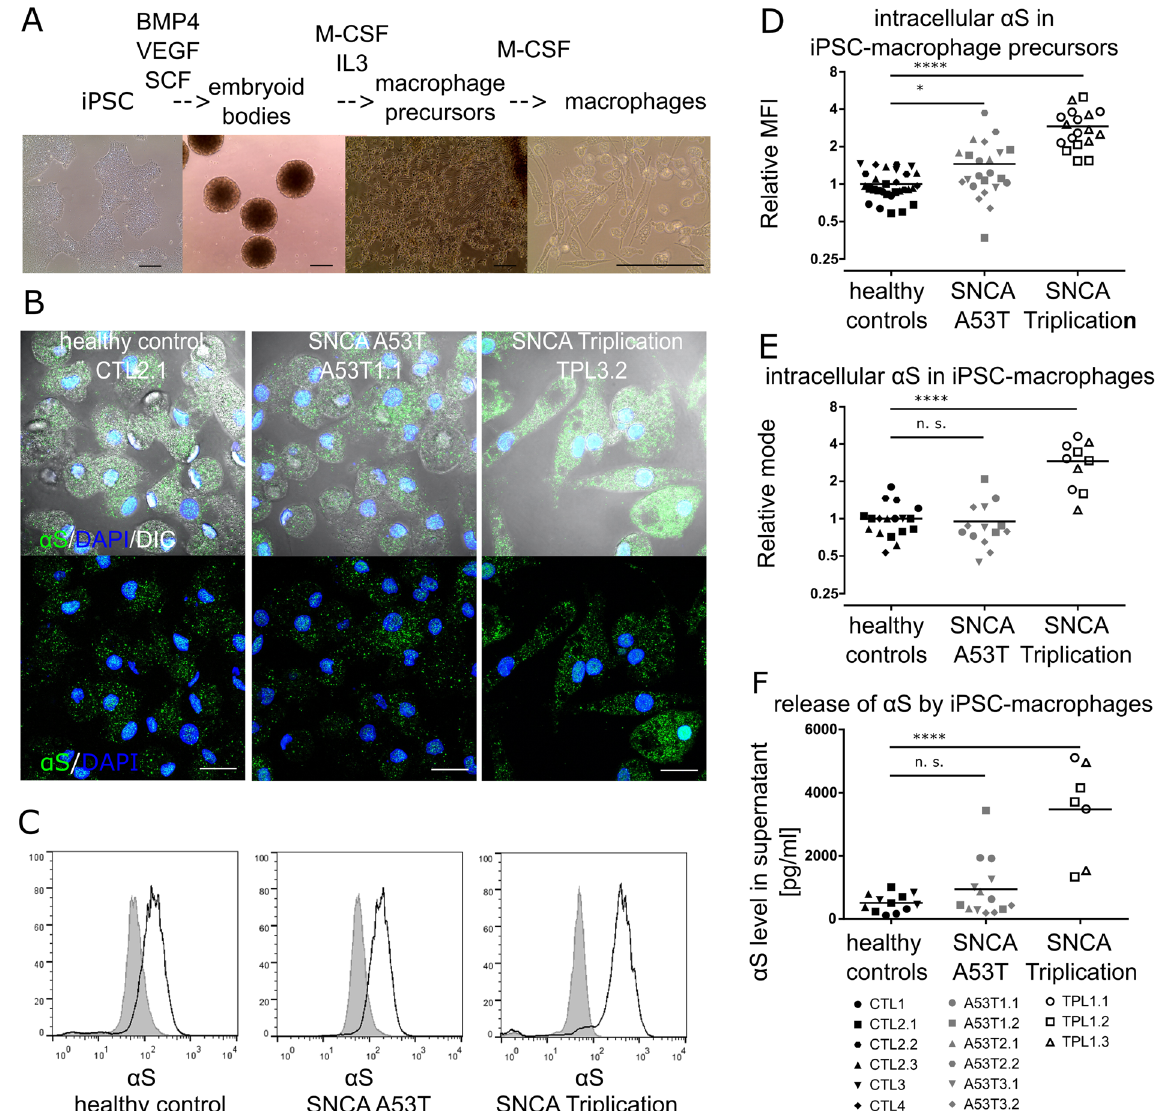
Figure 1. pMacpre and pMac expression of α S. ( A ) iPSC differentiation to macrophages (scale bar = 200 µ m). ( B ) Intracellular staining for α S in pMac, representative z projected confocal images (scale bar = 20 µ m). ( C , D , E ) Intracellular levels of α S by flow cytometry: ( C ) Representative α S FACs plots of pMacpre; ( D ) pMacpre α S levels (geometric mean fluorescence intensity, MFI); ( E ) pMac α S levels. ( F ) α S levels in 7-day supernatant from pMac. Values normalized to WT mean for each independent experiment. Also see Figs S1–3 Statistical analyses, one way ANOVA with Dunnett’s multiple comparisons